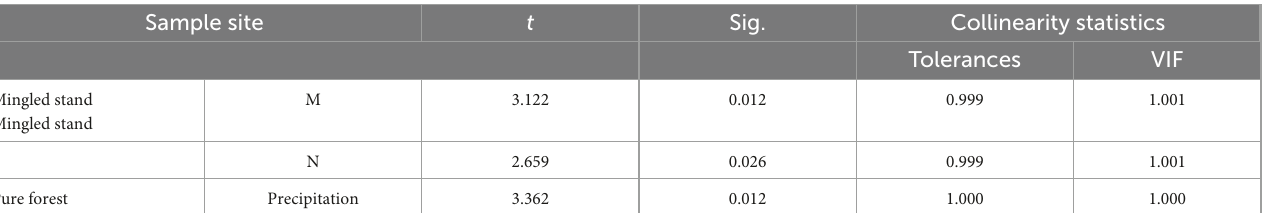
TABLE 5 Coefficients a